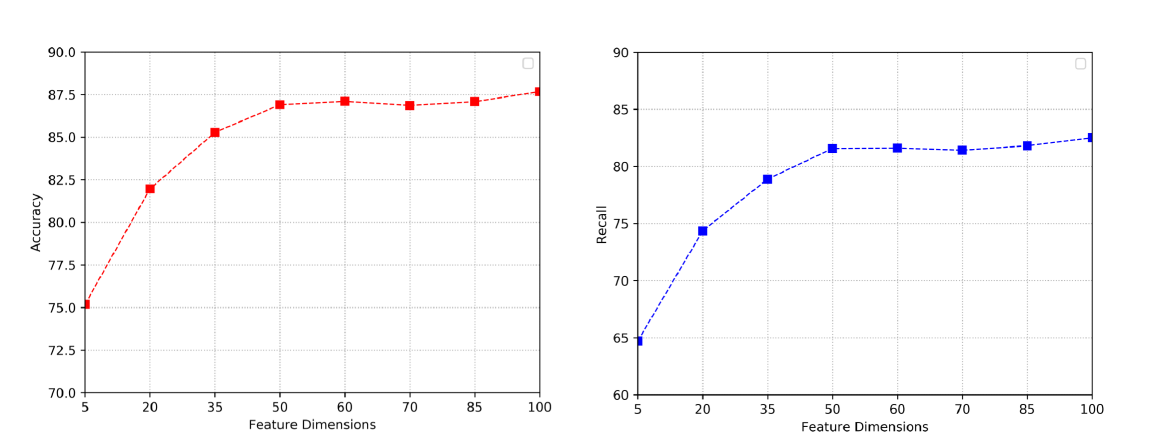
Figure 4. Accuracy and recall of the SPC model with the impact of different feature dimensions.